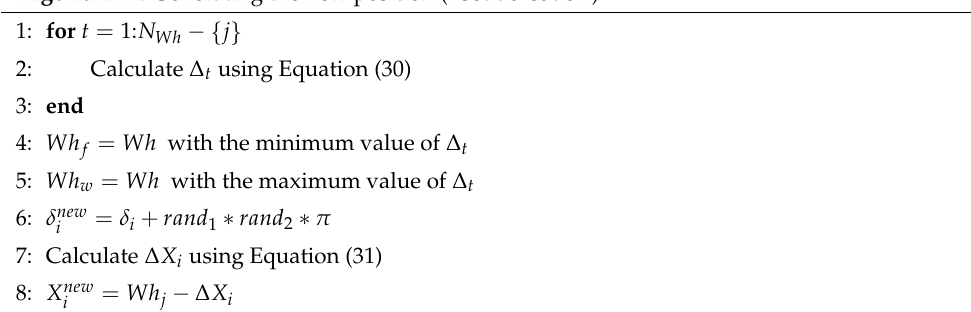
Algorithm 1. Generating the new position (Pseudo-code 1)